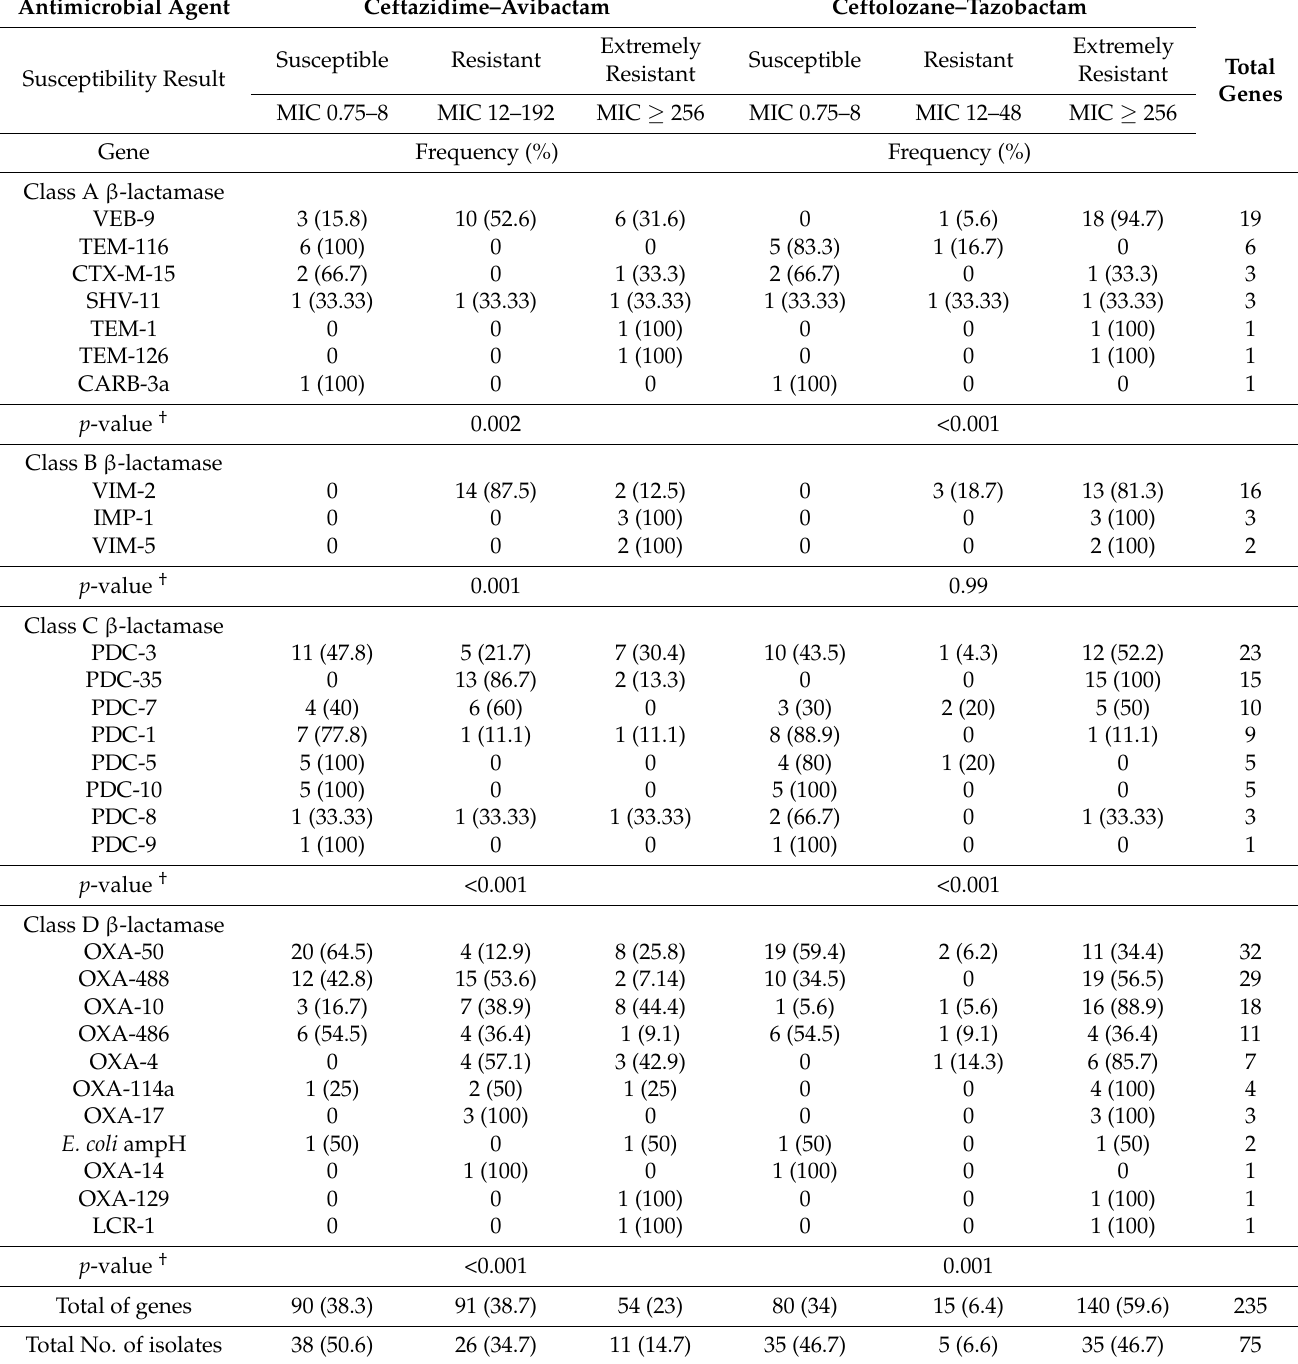
Table 3. The distribution of different β -lactamase genes associated with their minimum inhibitory concentration (MIC) values of ceftazidime–avibactam and ceftolozane–tazobactam. Antimicrobial